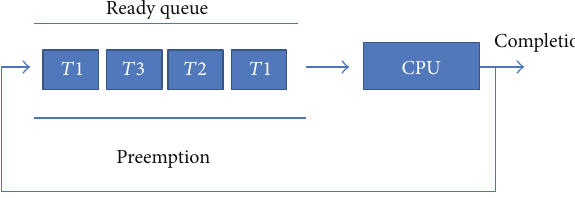
Figure 1: Round robin